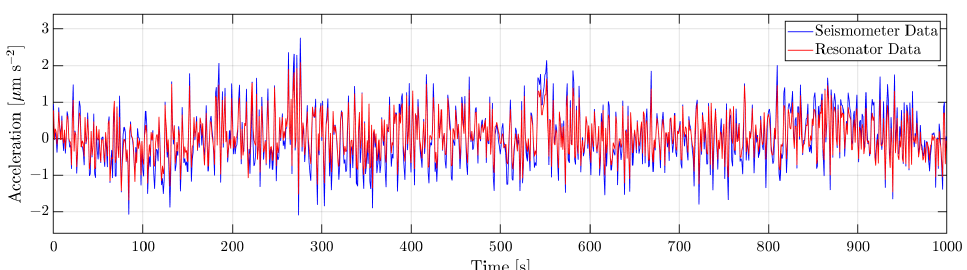
Figure 13. A 1000-s-long subset of the acceleration time series obtained by our optomechanical accelerometer and seismometer, in which we see excellent agreement between the two time series. Both traces are high-pass filtered above 0.8mHz for better comparison of the frequency band with high